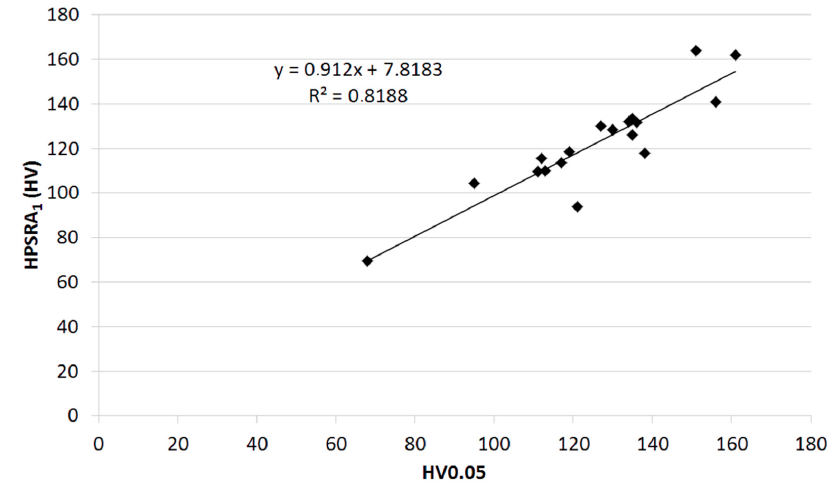
Figure 5. Relation between HV0.05 and HPSRA 1